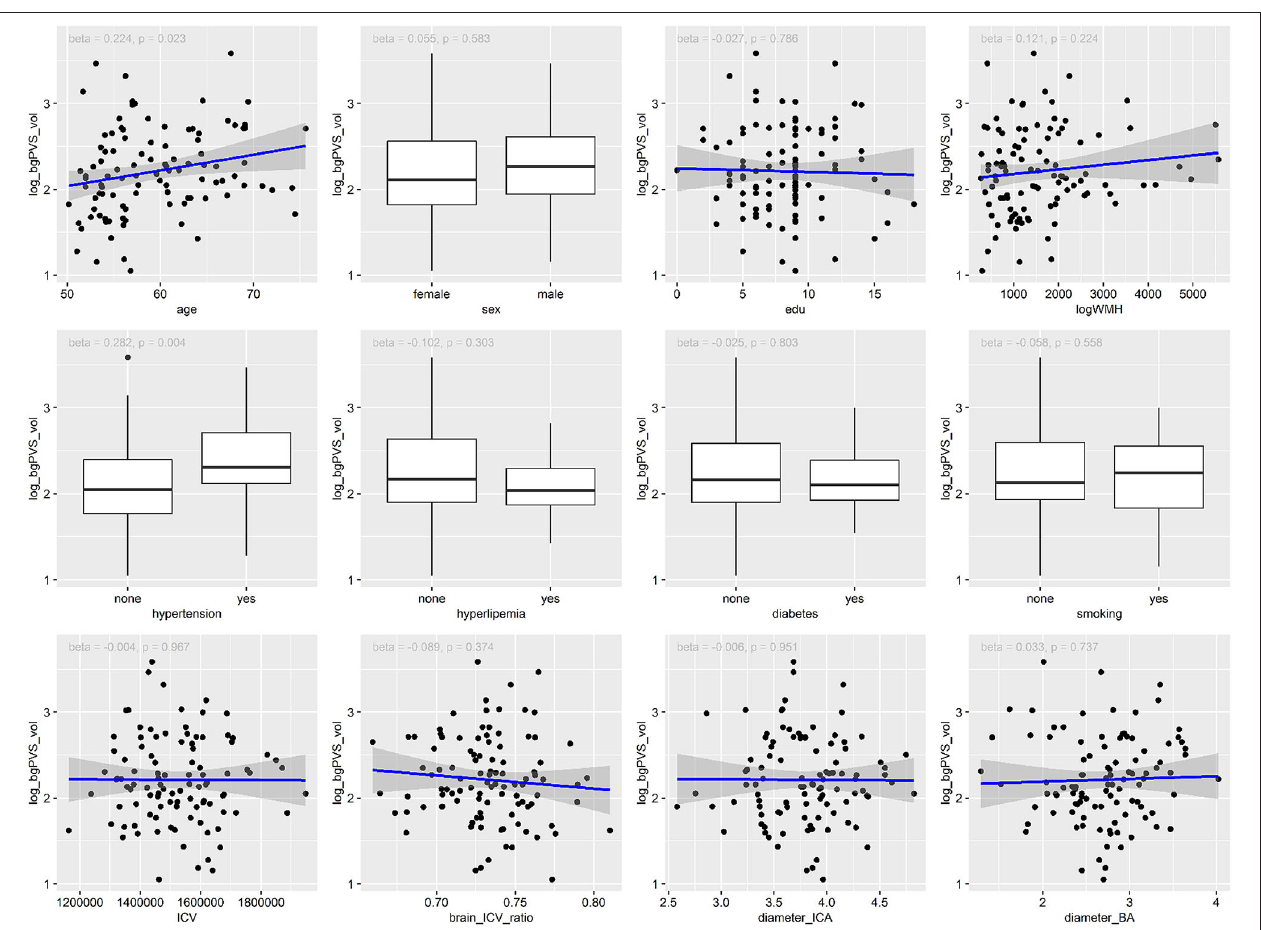
FIGURE 2 | Association between risk factors and the volume of